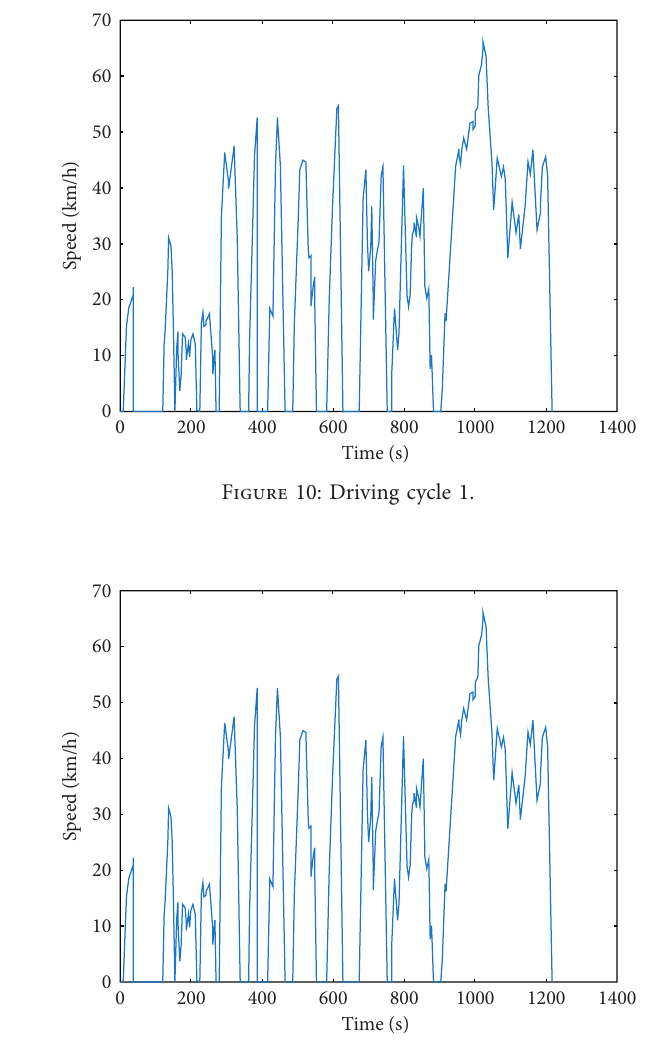
Figure 11: Driving cycle 2.